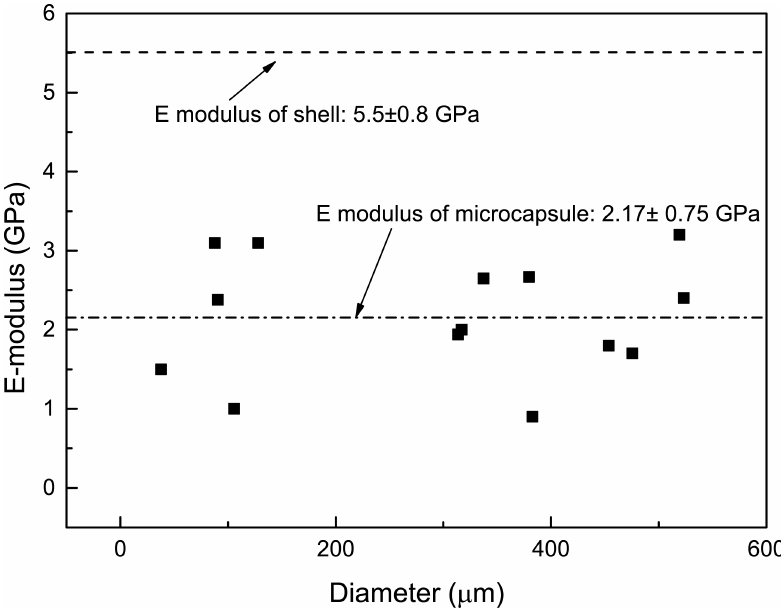
Figure 9. Elastic modulus of shell material and PF microcapsules, and its relationship with the diameter of